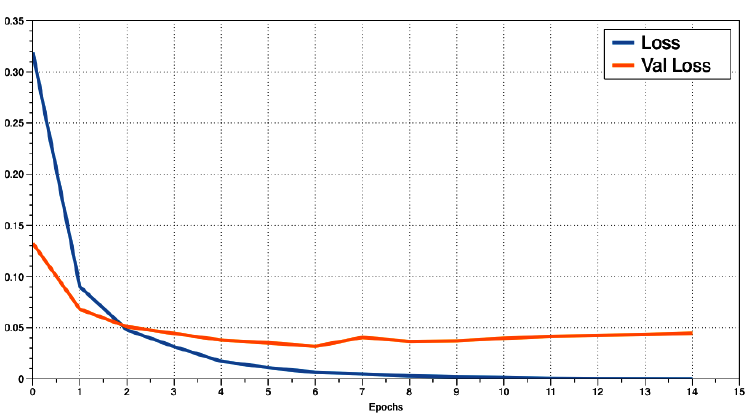
Figure 4. Training Loss versus validation loss using 5% of the training data where the x -axis is the epoch and the y -axis is the loss.